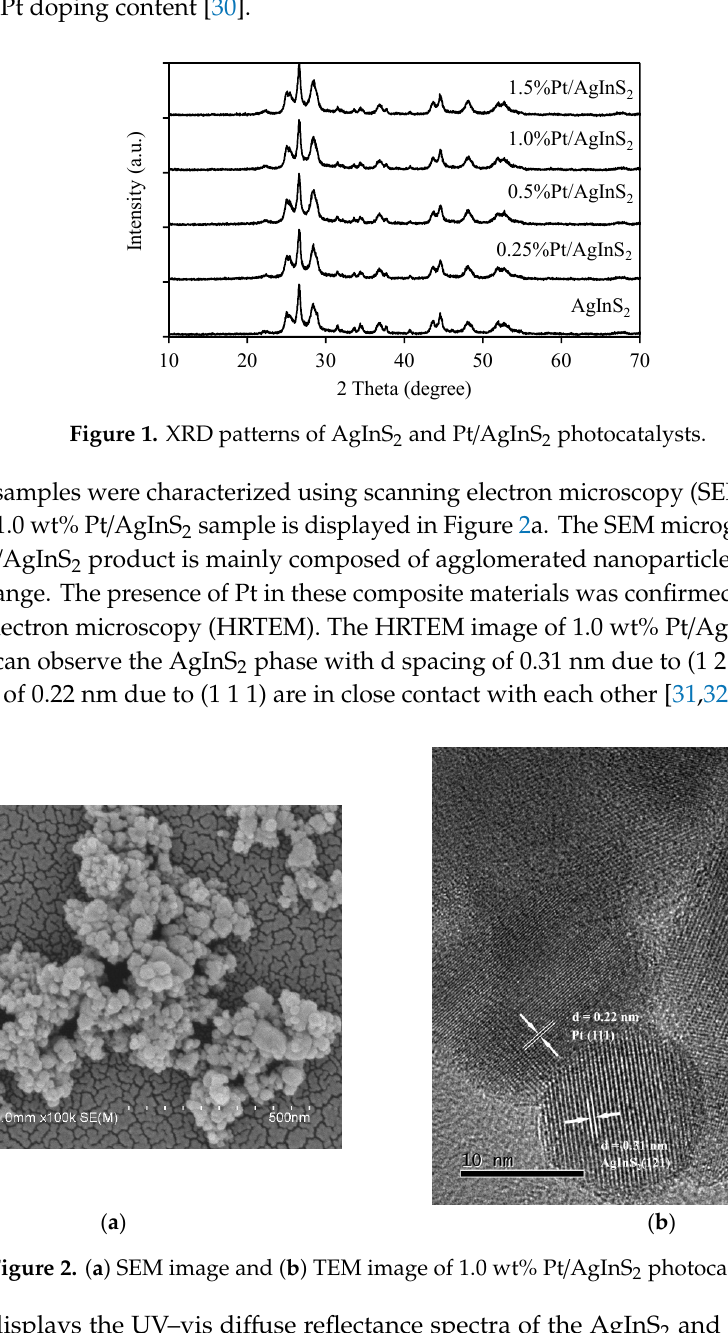
Figure 2. ( a ) SEM image and ( b ) TEM image of 1.0 wt% Pt/AgInS 2 photocatalyst.